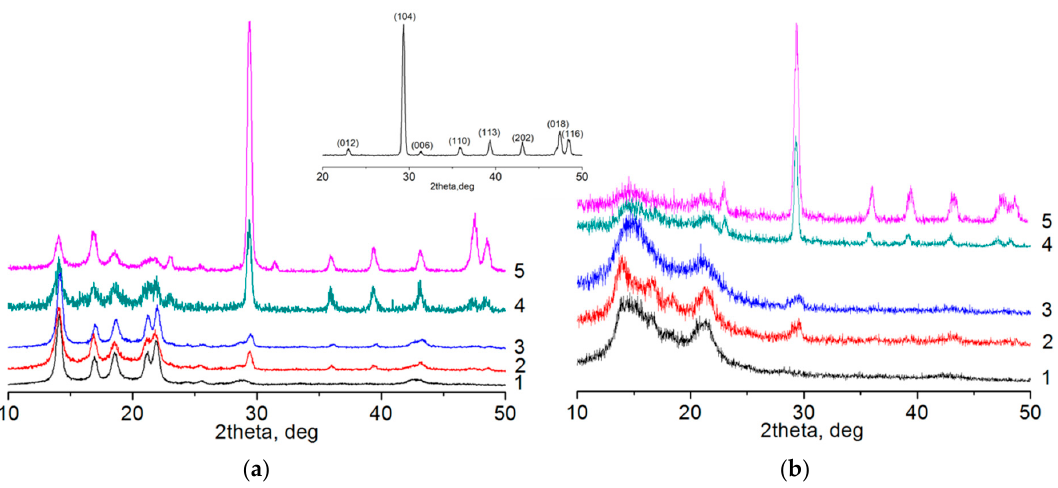
Figure 5. XRD patterns of films ( a ) and nonwovens ( b ) from pure PP (1) and composites of 95PP+5CC (2), (95PP+5CC)+SS (3), (70PP+30CC)+SS (4), (50PP+50CC)+SS (5). Inset—pattern of CaCO 3 powder.